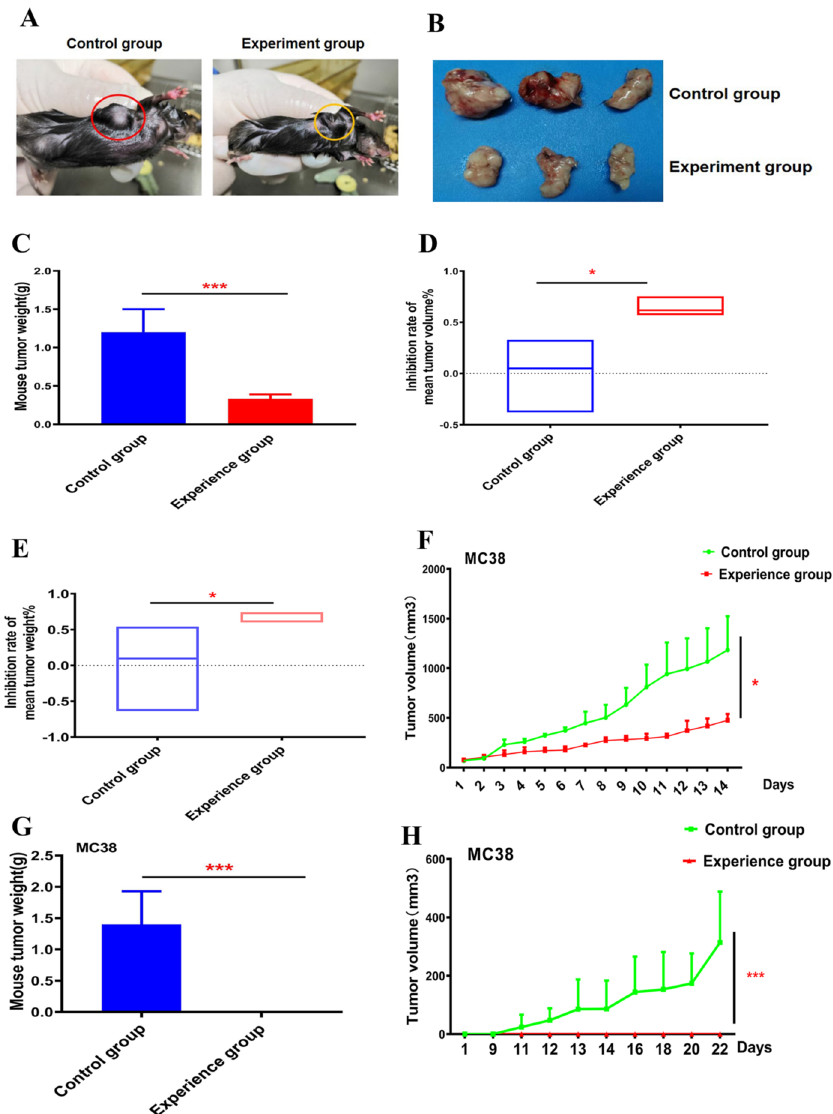
Figure 4. The therapeutic effect of type A blood antigen on tumor. ( A – F ) Five days after MC38 cell inoculation, the tumor reached a certain size and started to be injected with lentivirus carrying blood group A antigen. After 15 days, the tumor changes of the two groups of mice were compared. ( A ) Representative pictures of mouse subcutaneous tumors. ( B ) A representative picture of mouse tumors was taken. ( C ) Compare the changes in tumor weight between the two groups of mice. Student’s t-test, mean ± SD, *** P < 0.001. ( D ) Inhibition of tumor volume growth by blood group A antigen, calculation formula: tumor volume of mice in the treatment group minus the average tumor volume of control mice, divided by The average tumor volume of control mice. Student’s t-test, mean ± SD, * P < 0.05. ( E ) The inhibition of blood group A antigen on tumor weight, the calculation formula: the tumor weight of the mice in the treatment group minus the average weight of the tumor of the control mice, divided by the control Average weight of mouse tumors. Student’s t-test, mean ± SD, * P < 0.05. ( F ) Record tumor growth and draw growth curve. Student’s t-test, mean ± SD, * P < 0.05. One day after ( G , H ) MC38 cells were inoculated, the injection of lentivirus carrying blood group A antigen was started when the tumor formed. ( G ) After 15 days, compare the changes of tumor weight between the two groups of mice. Student’s t-test, mean ± SD, *** P < 0.001. ( H ) Record tumor growth and draw growth curve. Student’s t-test, mean ± SD, * P <